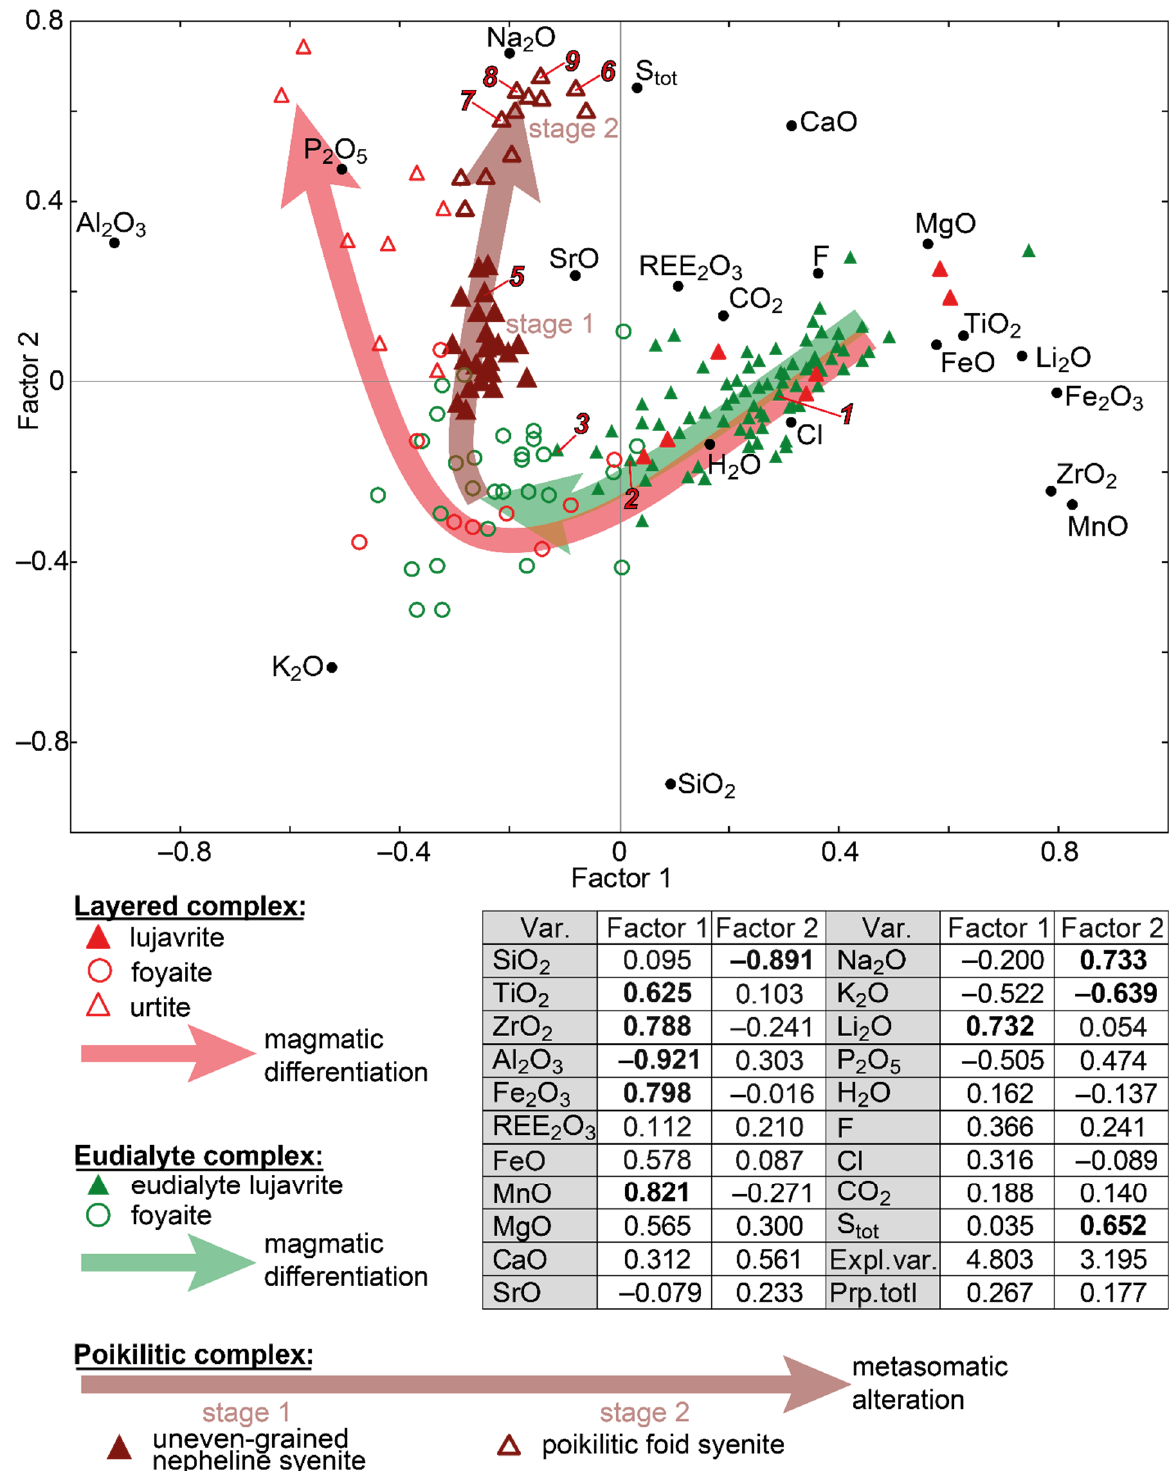
Figure 9. Results of factor analyses of data on the chemical composition of rocks of the Eudialyte [54], Layered, and poikilitic complexes. Points 1–3 correspond to eudialyte lujavrite near the contact of poikilitic foid syenite (see Figures 3b and 7); points 5–9 correspond to poikilitic rocks (see Figure 3b); the point corresponding to sample 4 is absent because this sample is a pegmatoid zone at the contact of poikilitic syenite and lujavrite with a very variable modal composition. Var.—variables; Expl.var.—explained variance; Prp.totl—proportion of total variance. Factor loadings > |0.6| are shown in bold.